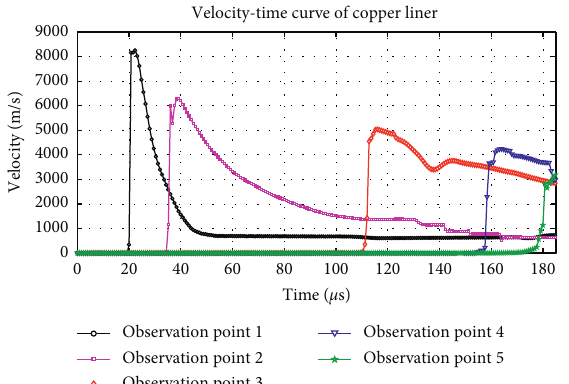
Figure 6: SCJ velocity curve of the copper